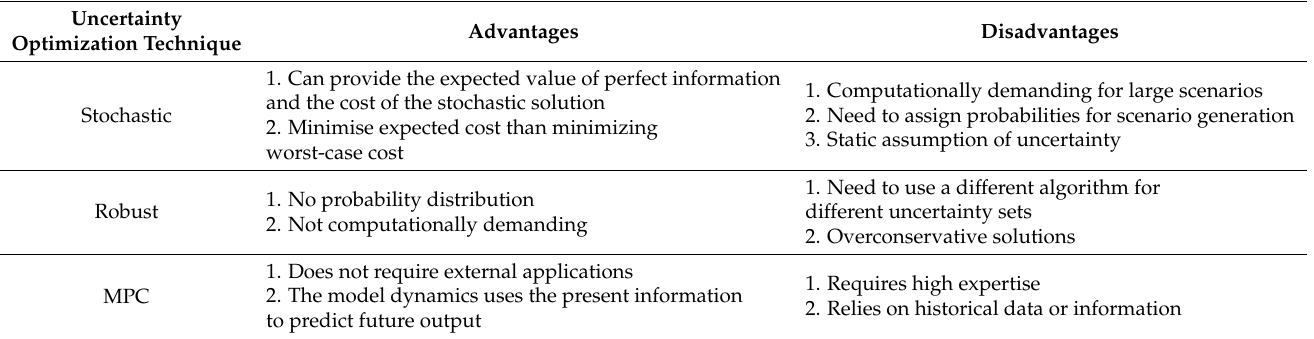
Uncertainty Optimization Technique